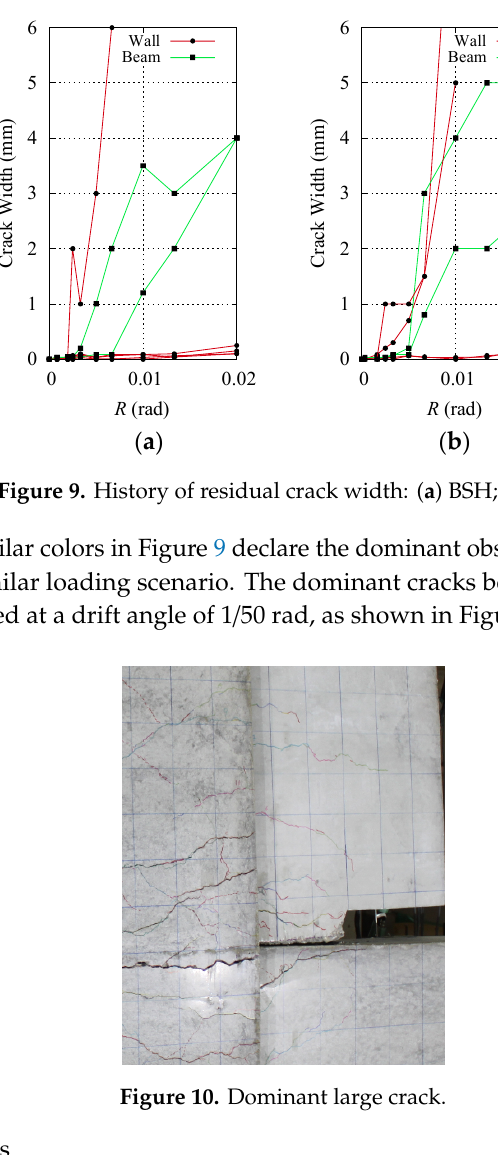
Figure 8. Crack patterns at 1/100 drift: ( a ) BSH; ( b ) BS.